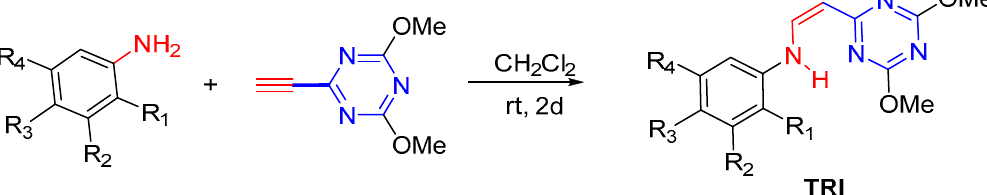
Figure 9. General pathway for the synthesis of TRI compounds.